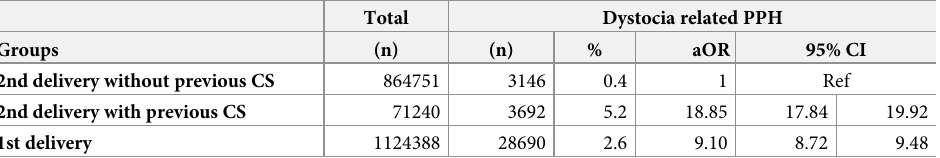
Table 5. Risk of postpartum hemorrhage (PPH > 500ml) due to dystocia in second deliveries without previous cesarean section (CS) (reference), second deliveries with previous CS, and first deliveries; singleton births, � 22 weeks of gestation and spontaneous onset or induction of